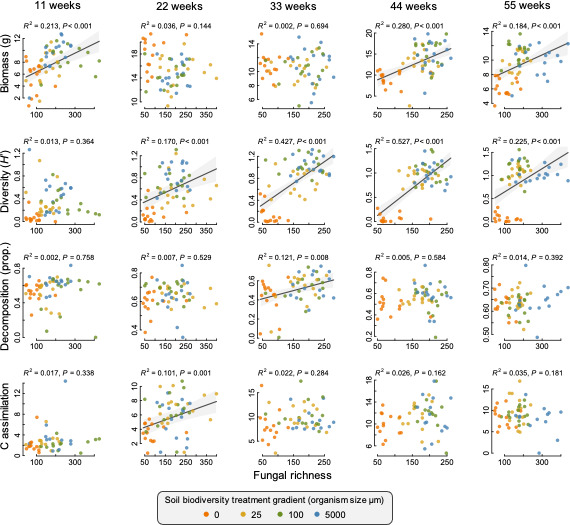
Fungal richness-ecosystem function relationships for each time point.Solid lines indicate a significant relationship (p<0.05), and the grey shaded region is the 95% confidence band for the relationship. Fit statistics (R2 and p-value) for each are also provided above each plot. Points are individual mesocosms coloured by their soil biodiversity treatment.